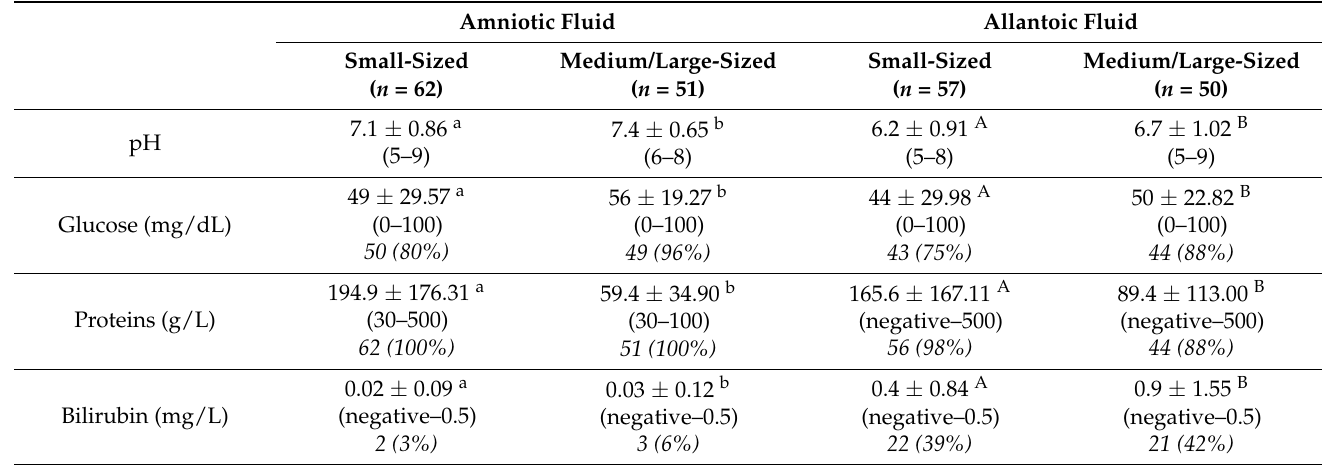
Table 2. Data about the mean ± SD (range) and the number and percentage of samples’ positivity (italic) for the significant parameters in the 113 amniotic and 107 allantoic canine fluid samples collected from surviving puppies, grouped according to breed